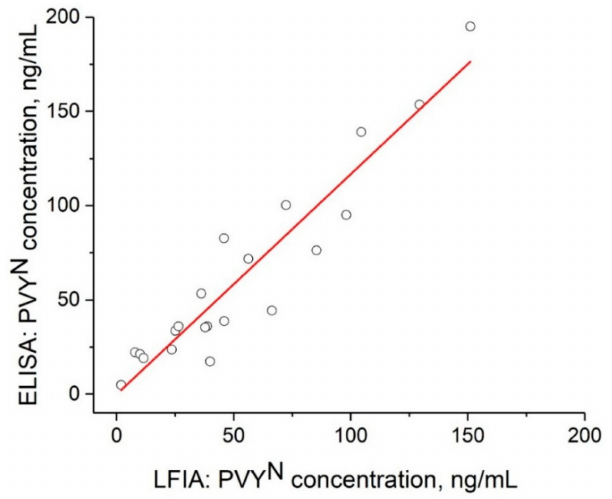
Figure 11. The correlation of the PVX concentration in a potato leaf extract as determined by LFIA and ELISA. The circles represent the experimental data; the solid line represents the linear approximation.